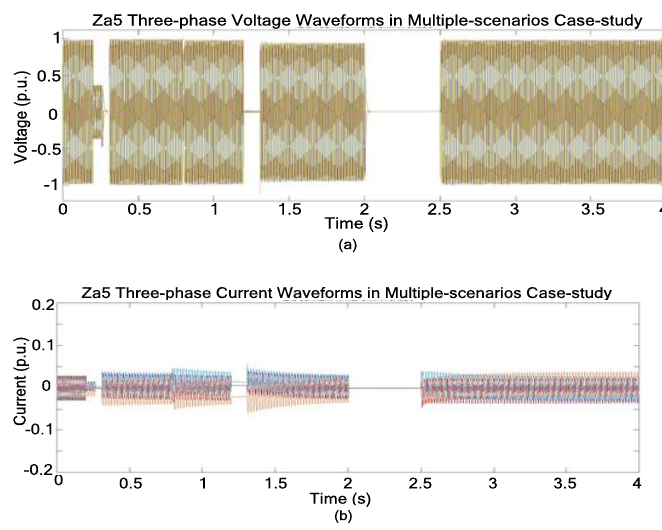
Figure 10. Za5 waveforms in the multiple-scenario case study; ( a ) voltage, ( b ) current. Table 3. Restoration results for the multi-scenario case study.